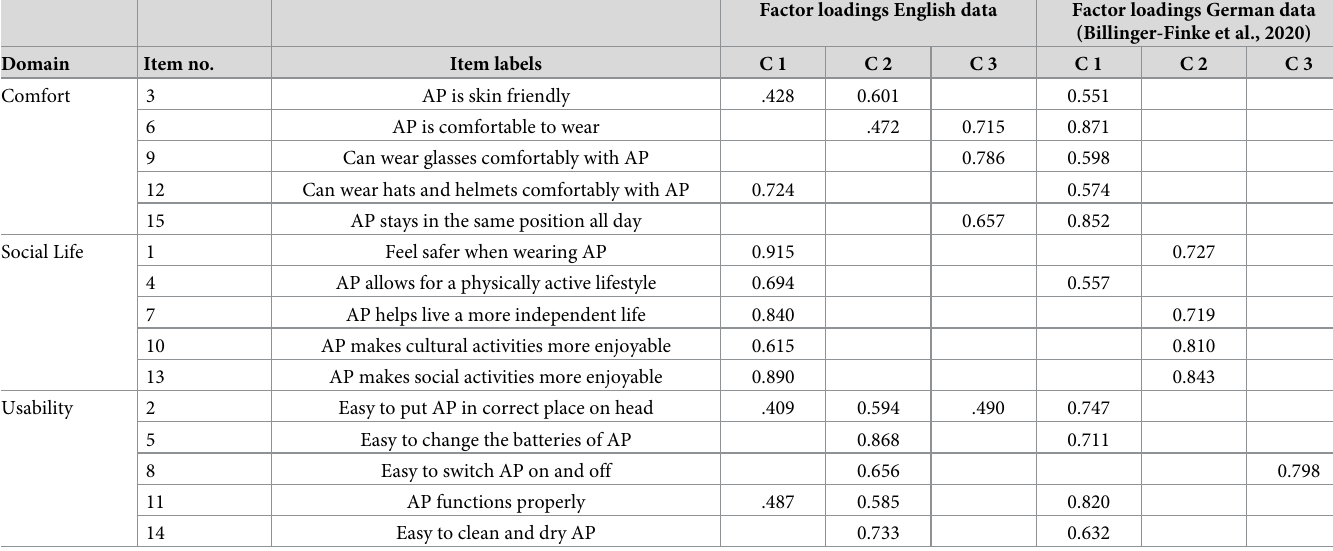
Table 3. Results from the factor analysis with a rotated quartimax factor solution (extraction method: Principal component analysis). Other factor loadings are marked in grey. C = components (i.e. factors); AP = audio processor.